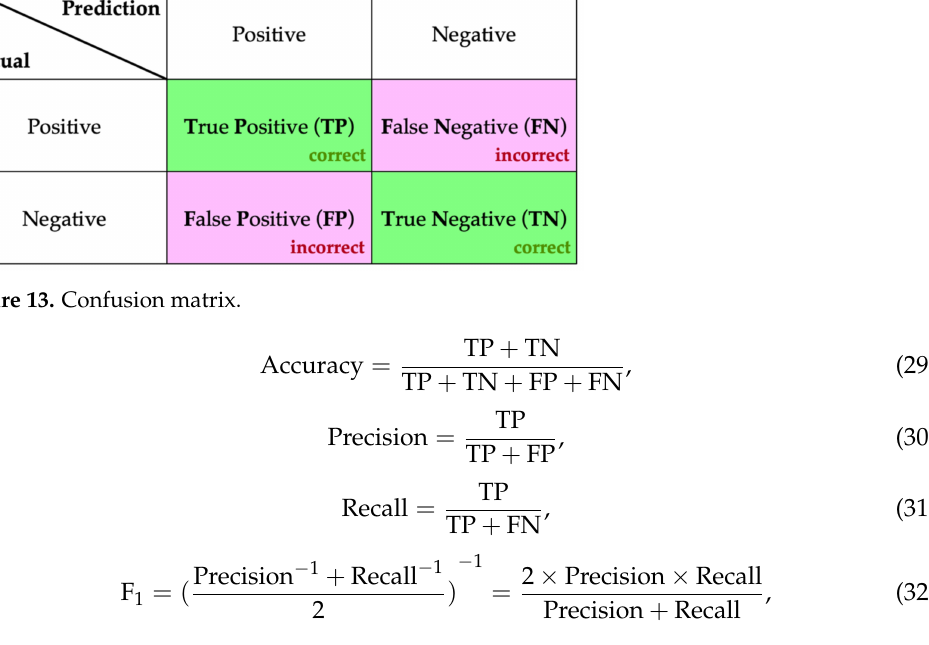
Table 3. The optimal values for each evaluation metric of the